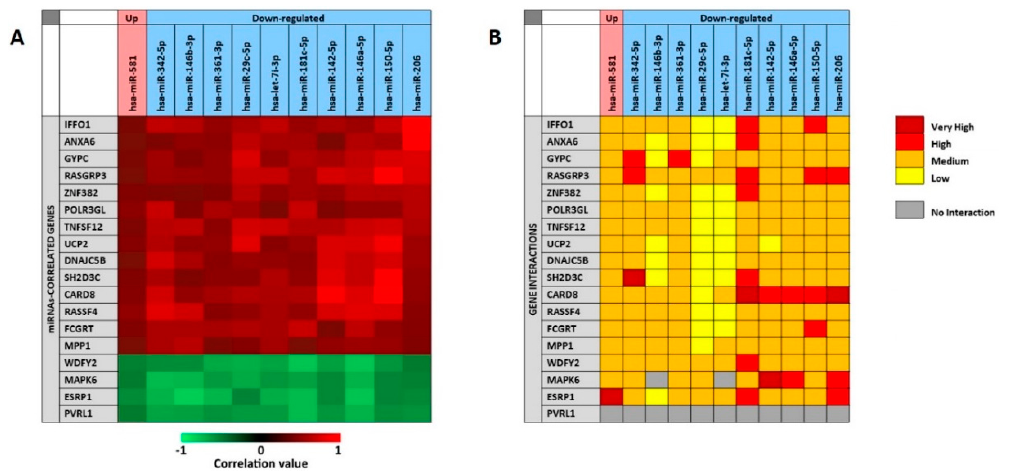
Figure 7. Panel ( A ) miRCancerdb analysis of genes whose expression is positively and negatively related to the 11 selected miRNAs; panel ( B ) mirDIP analysis of interaction levels between miRNAs and related genes.